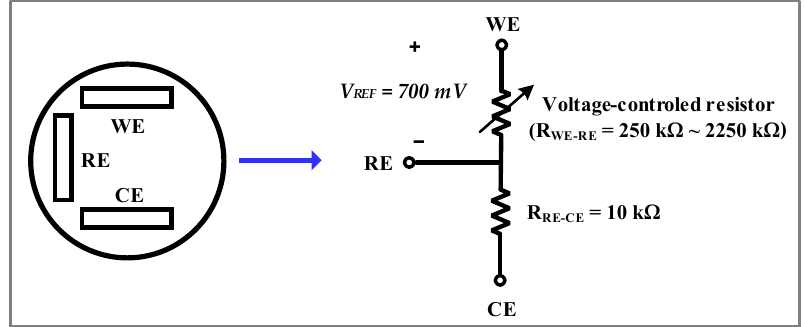
Figure 8. Configuration of the equivalent sensor model using a voltage-controlled resistor.